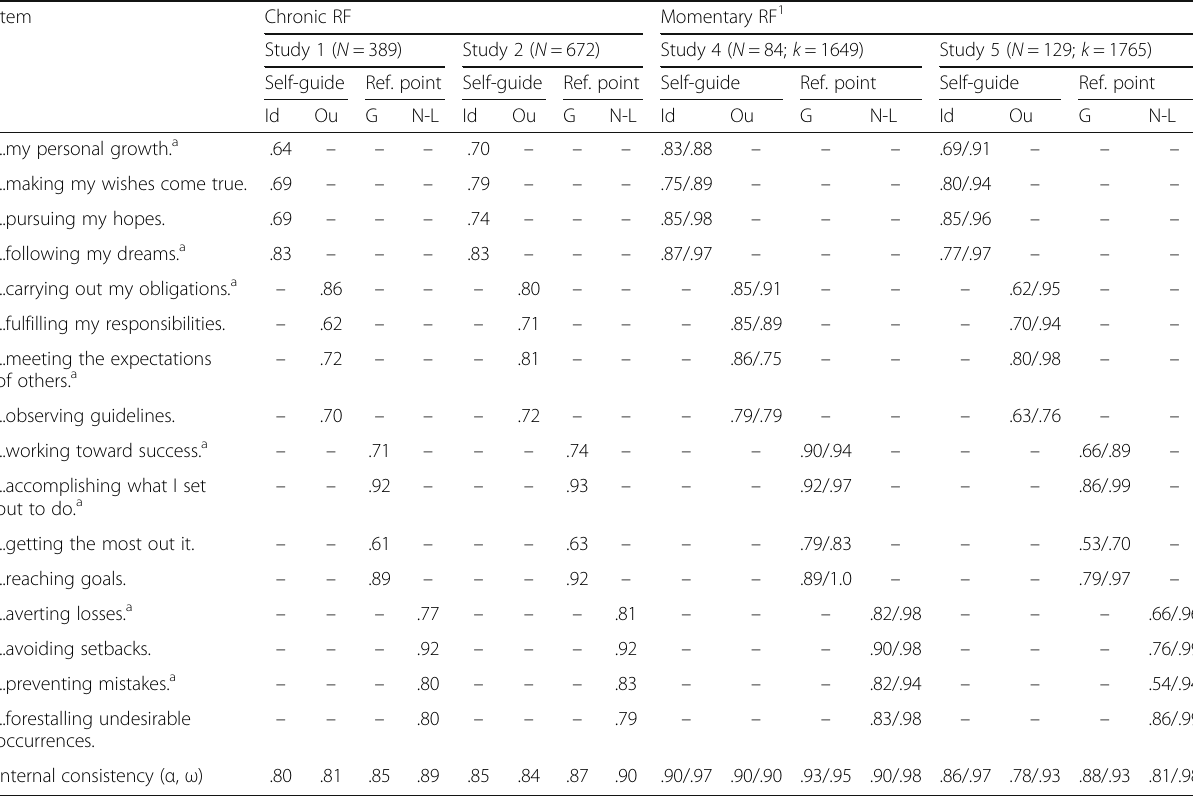
Table 2 Loadings for confirmatory factor analyses (standardized path coefficients) and internal consistencies by study Item